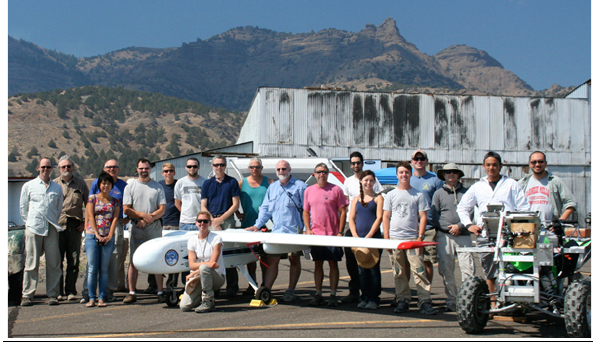
Figure 2. SIERRA UAS with project crew in Surprise Valley